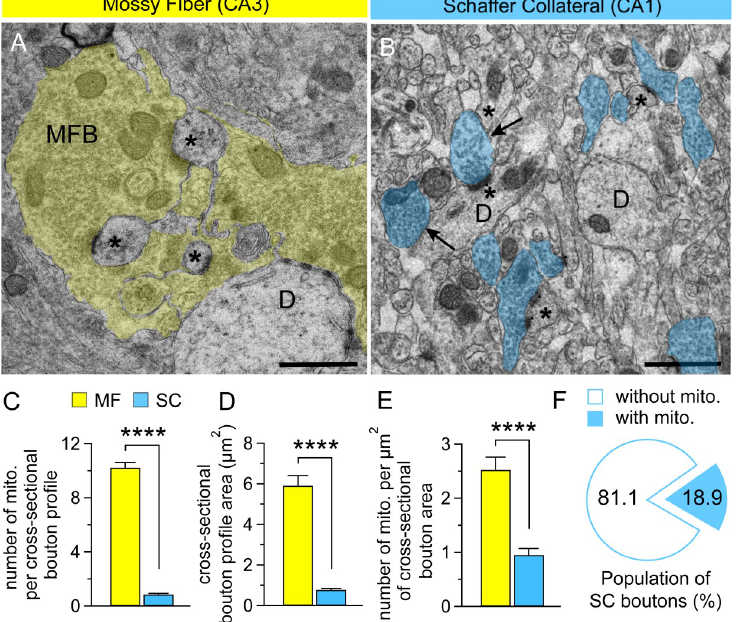
Fig 1. Comparison of mitochondrial number at MF and SC presynaptic bouton profiles. ( A ) A transmission electron micrograph of hippocampal stratum lucidum in area CA3 showing large cross-sectional mossy fiber bouton profiles (MFB: highlighted in yellow) establishing synaptic contacts with large complex spines of CA3 pyramidal neuron dendrites at multiple sites. Asterisk: spine, D: dendrite, Scale bar: 1 μ m. ( B ) A transmission electron micrograph of hippocampal stratum radiatum in area CA1 showing cross-sectional dendrite profiles of CA1 pyramidal neurons and the neuropil in-between, which contains abundant cross-sectional presynaptic bouton and dendritic spine profiles. The cross-sectional areas of the bouton profiles are highlighted in blue. Arrows indicate cross-sectional bouton profiles with or without mitochondria. Asterisk: spine, D: dendrite, Scale bar: 1 μ m. ( C ) Quantification of the number of mitochondria per cross-sectional bouton profile. Note that the cross-sectional MF bouton profiles contain many mitochondria, in contrast to the scarcity of mitochondria in the cross-sectional SC bouton profiles (MF: 10.22 ± 0.39, n = 45; SC: 0.84 ± 0.08, n = 45; MF vs . SC, p < 0.0001, unpaired t -test). ( D ) Quantification of the size of cross-sectional bouton profile area. The cross-sectional MF bouton profile areas are larger relative to the cross- sectional areas of SC bouton profiles (MF: 5.91 ± 0.49 μ m 2 , n = 48; SC: 0.77 ± 0.07 μ m 2 , n = 48; MF vs . SC, p < 0.0001,